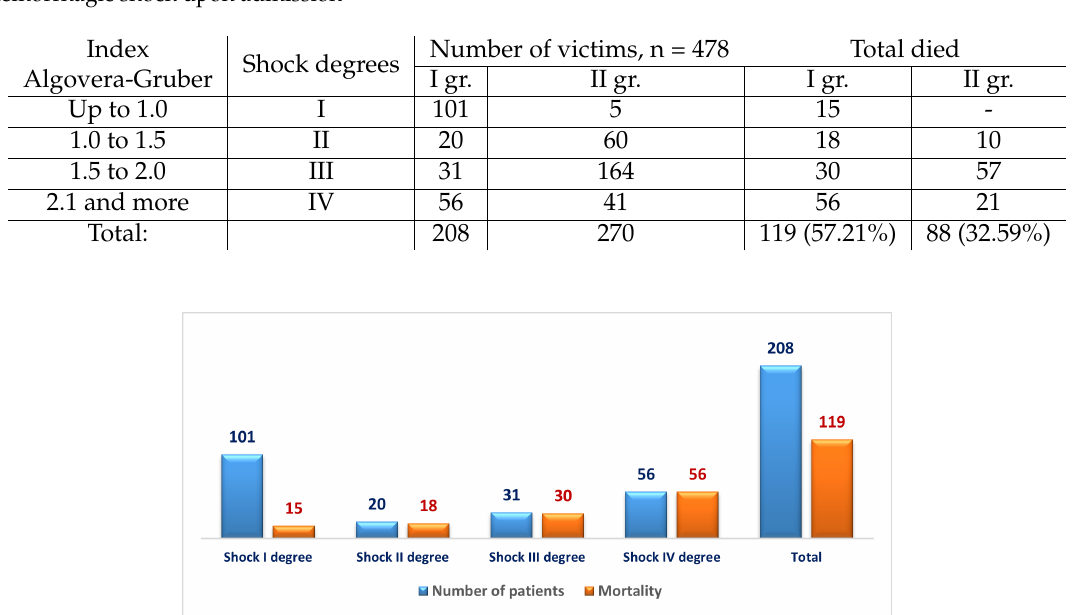
Table 1. Sorting of victims with concomitant trauma of the abdominal organs according to the severity of hemorrhagic shock upon admission